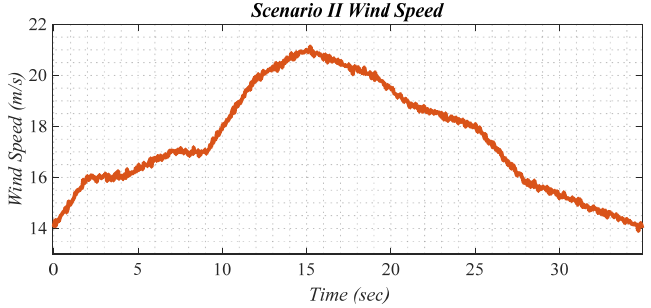
Figure 11. Random distribution of wind speed.